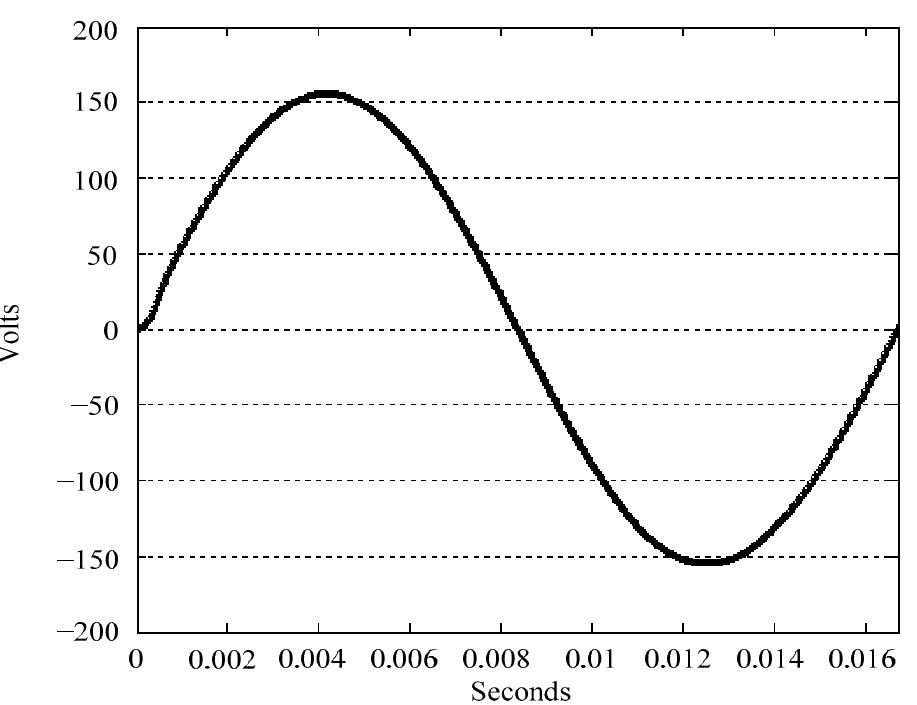
Figure 3. Simulated output voltage with the proposed technique under full load.